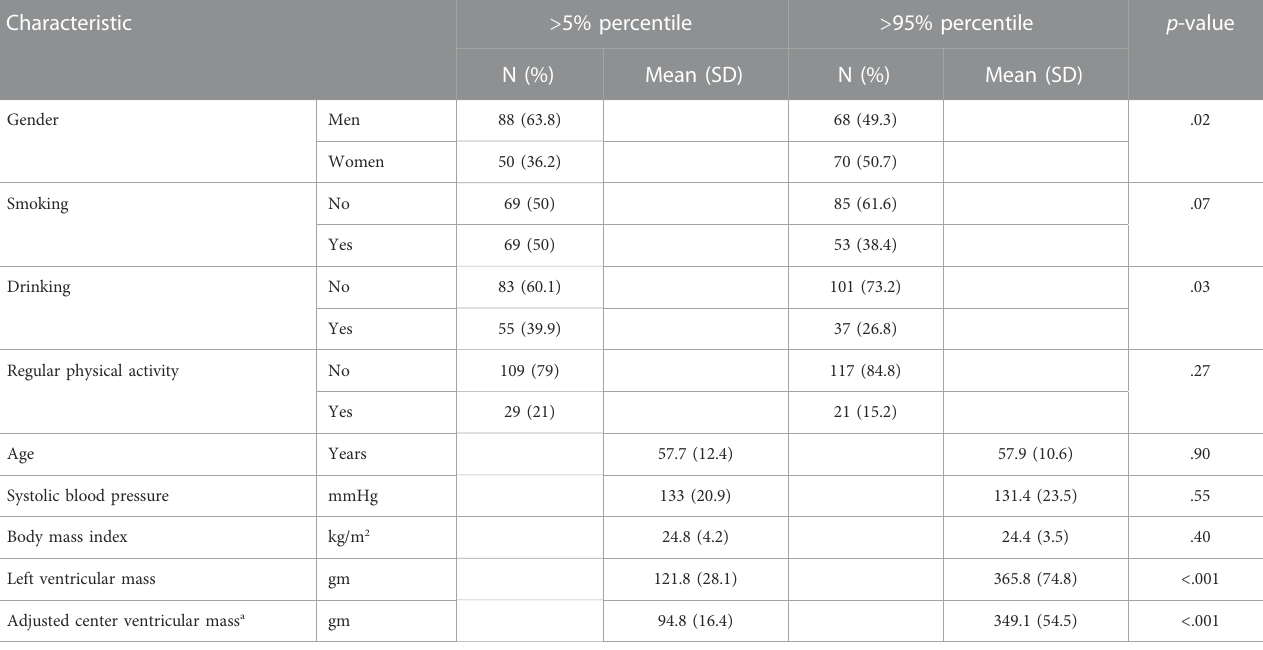
TABLE 1 Basic characteristics of the study participants, strati fi ed by the status of extreme groups of adjusted center ventricular mass ( < 5% vs. > 95%). Characteristic